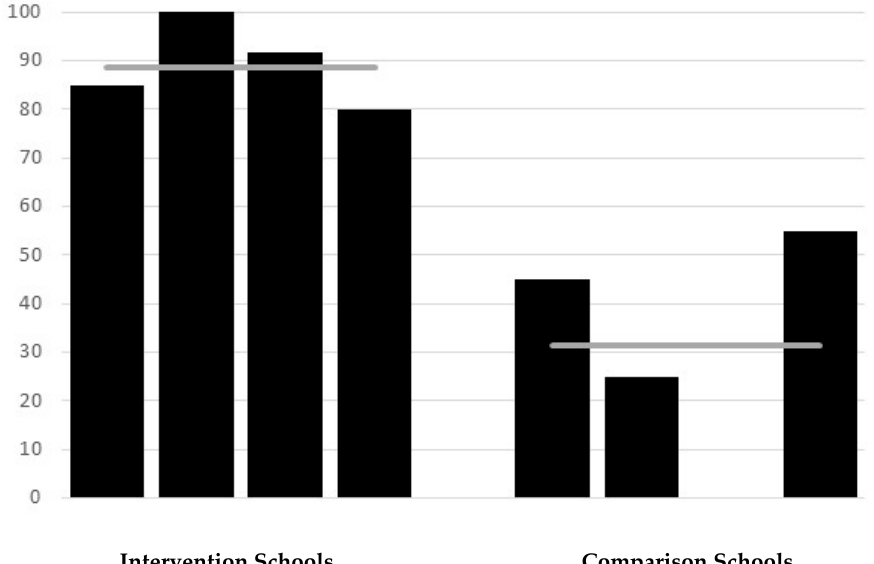
Figure 1. Direct observation of handwashing: percentage of children who washed hands after going to the toilet in intervention and comparison schools. Horizontal line represents the average for schools.